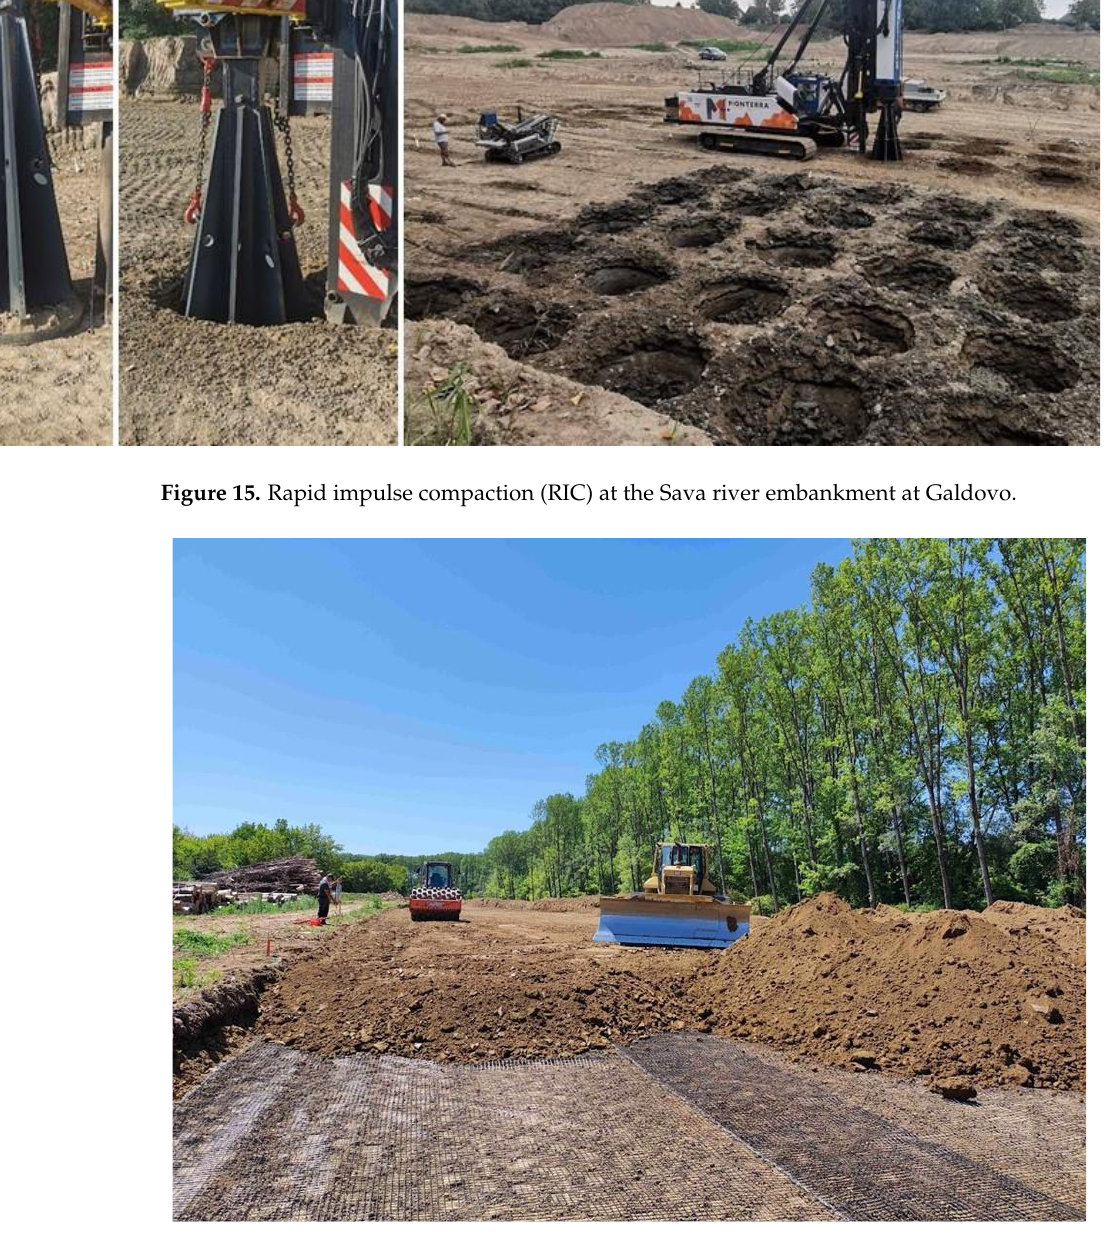
Figure 16. Installation of geogrids in the foundation soil of the Kupa embankment near Petrinja.